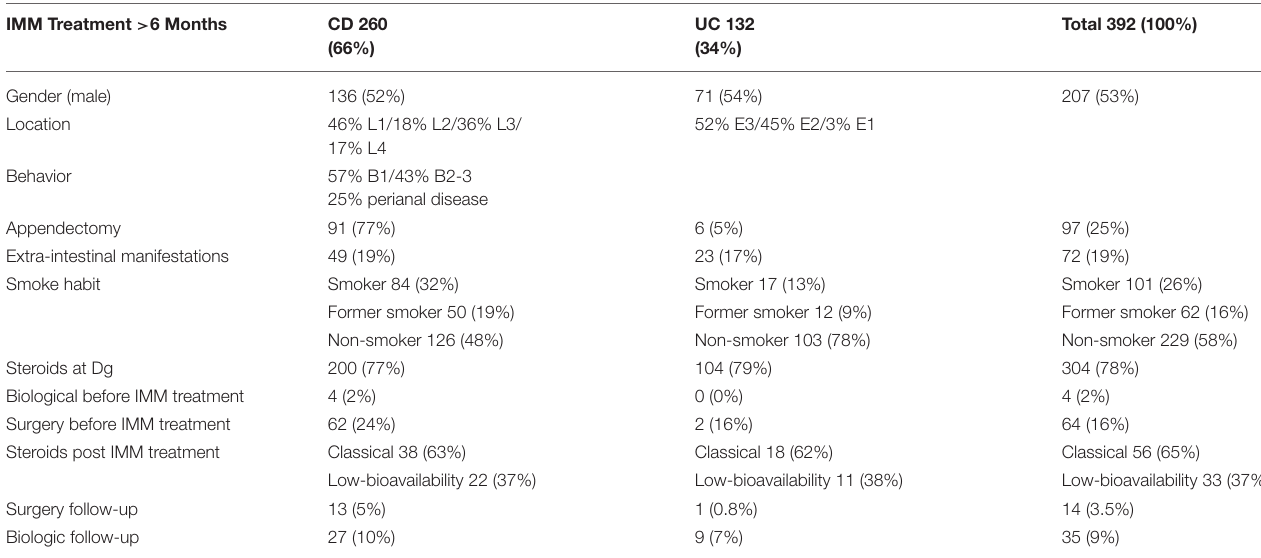
TABLE 2 | Baseline patient demographics and disease